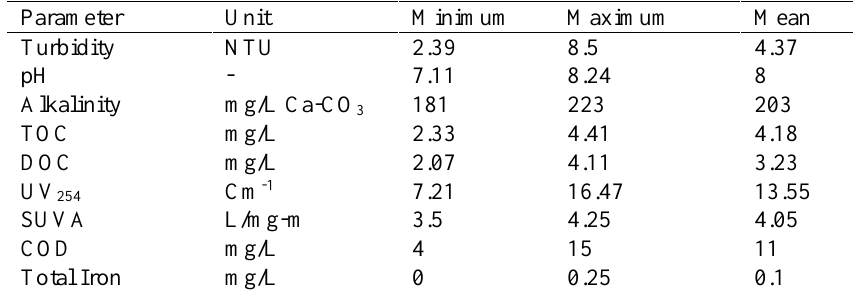
Table 1. Mean of raw water qualitative parameters in SWTP